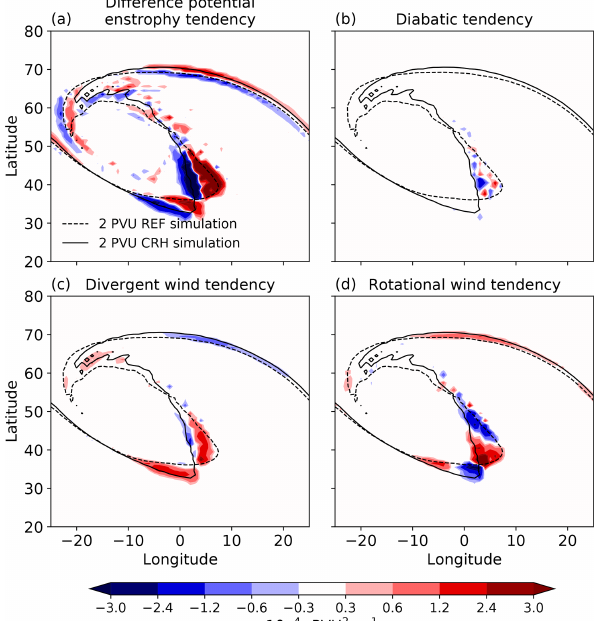
Figure 9. Spatial distribution of (a) difference potential enstrophy tendency and contributions from (b) diabatic processes as well as advection by the (c) divergent flow and (d) the rotational flow at day 7.5. The black contours show the dynamical tropopause for the cyclone with CRH (solid) and without CRH (dashed) on the 326K isentrope.